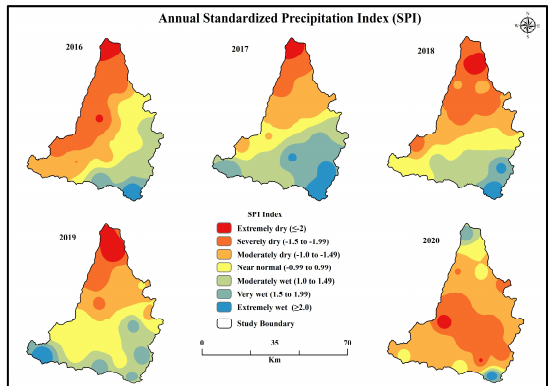
Figure 10: Annual Standardized Precipitation Index of 2016 to